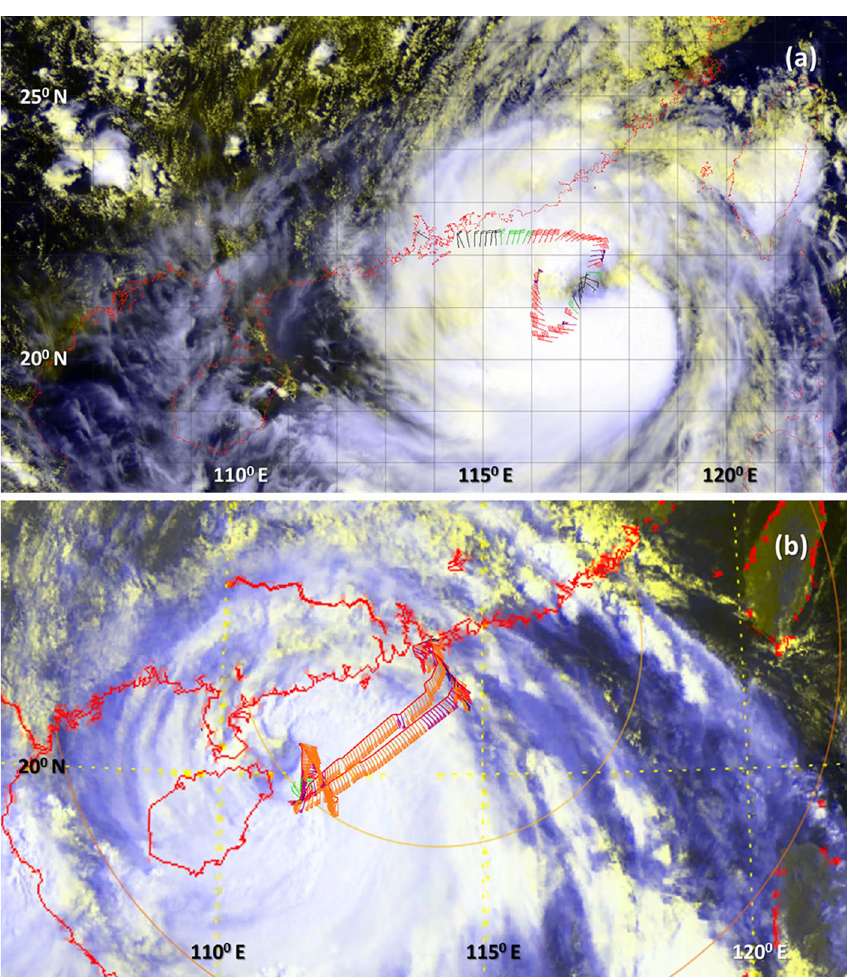
Figure 1. ( a ) Flight Track during Typhoon Nida and ( b ) Flight Track during Typhoon Kalmaegi. The wind bar donates the wind